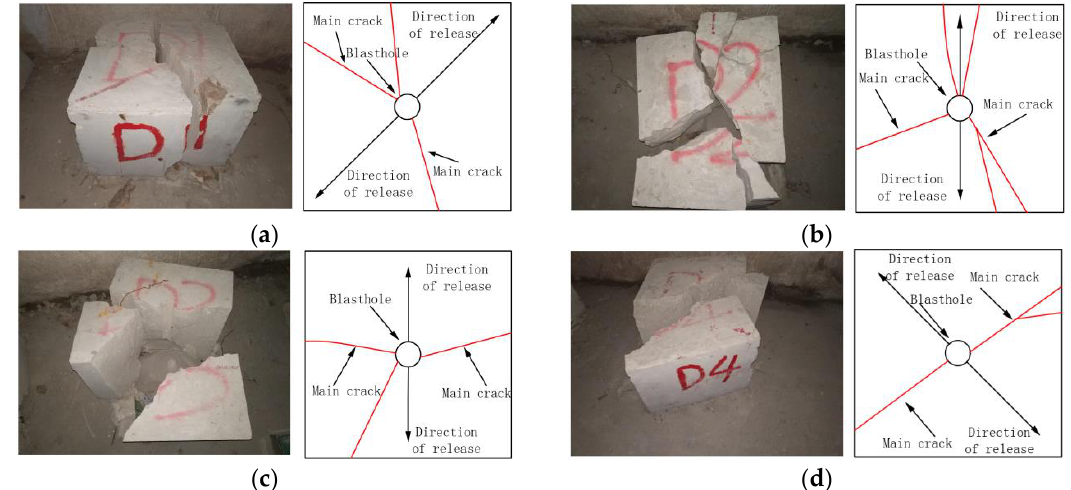
Figure 6. Fixed carbon dioxide splitter.